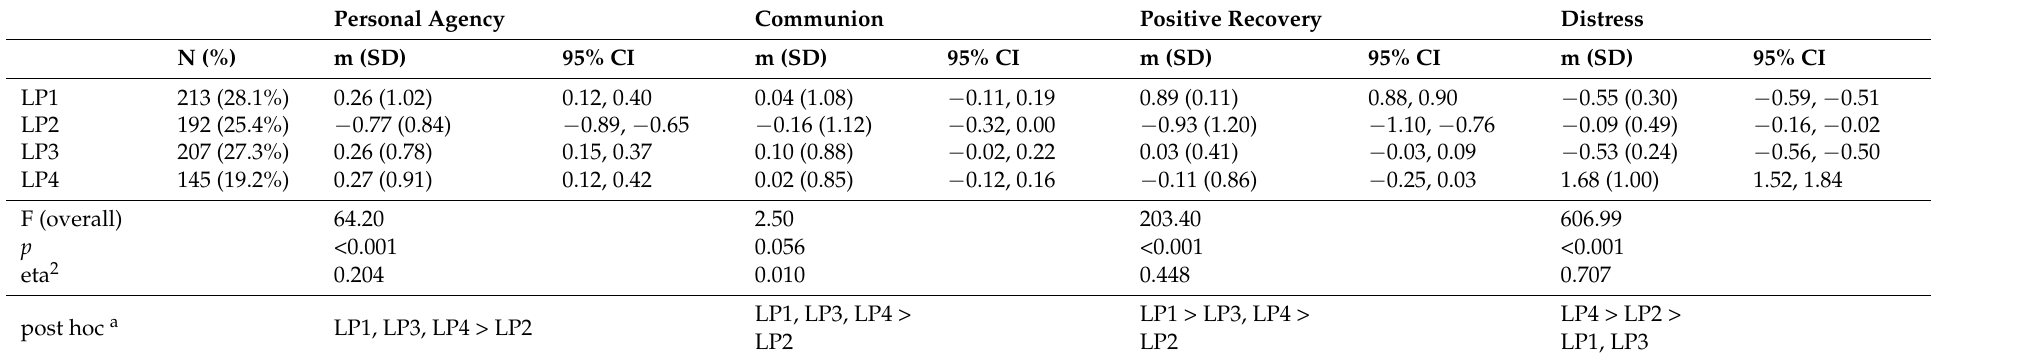
Table 4. Comparison of the latent profile groups along the place